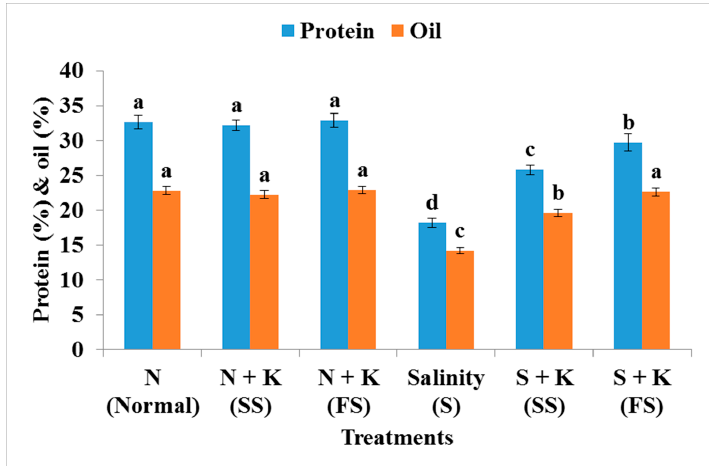
Figure 8. Effect of seed soaking (SS) and foliar spray (FS) of potassium (6 mM K 2 SO 4 ) on seed quality of soybean plants grown under normal (EC = 2.68 dS m − 1 ) and saline (EC = 7.46 dS m − 1 ) conditions. Means followed by the same letter in each parameter are not significantly different according to the LSD test ( p ≤ 0.05). Error bars are ± Standard Error (SE).